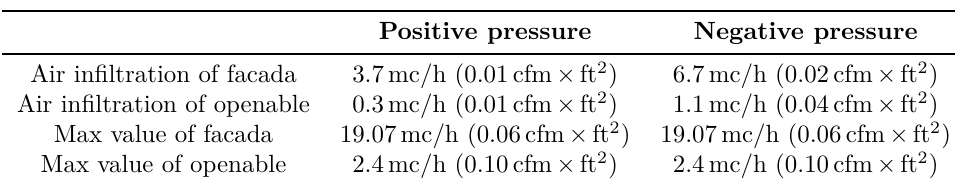
Table 1. Air infiltration test for the mock-up 01 in positive and negative pressure.